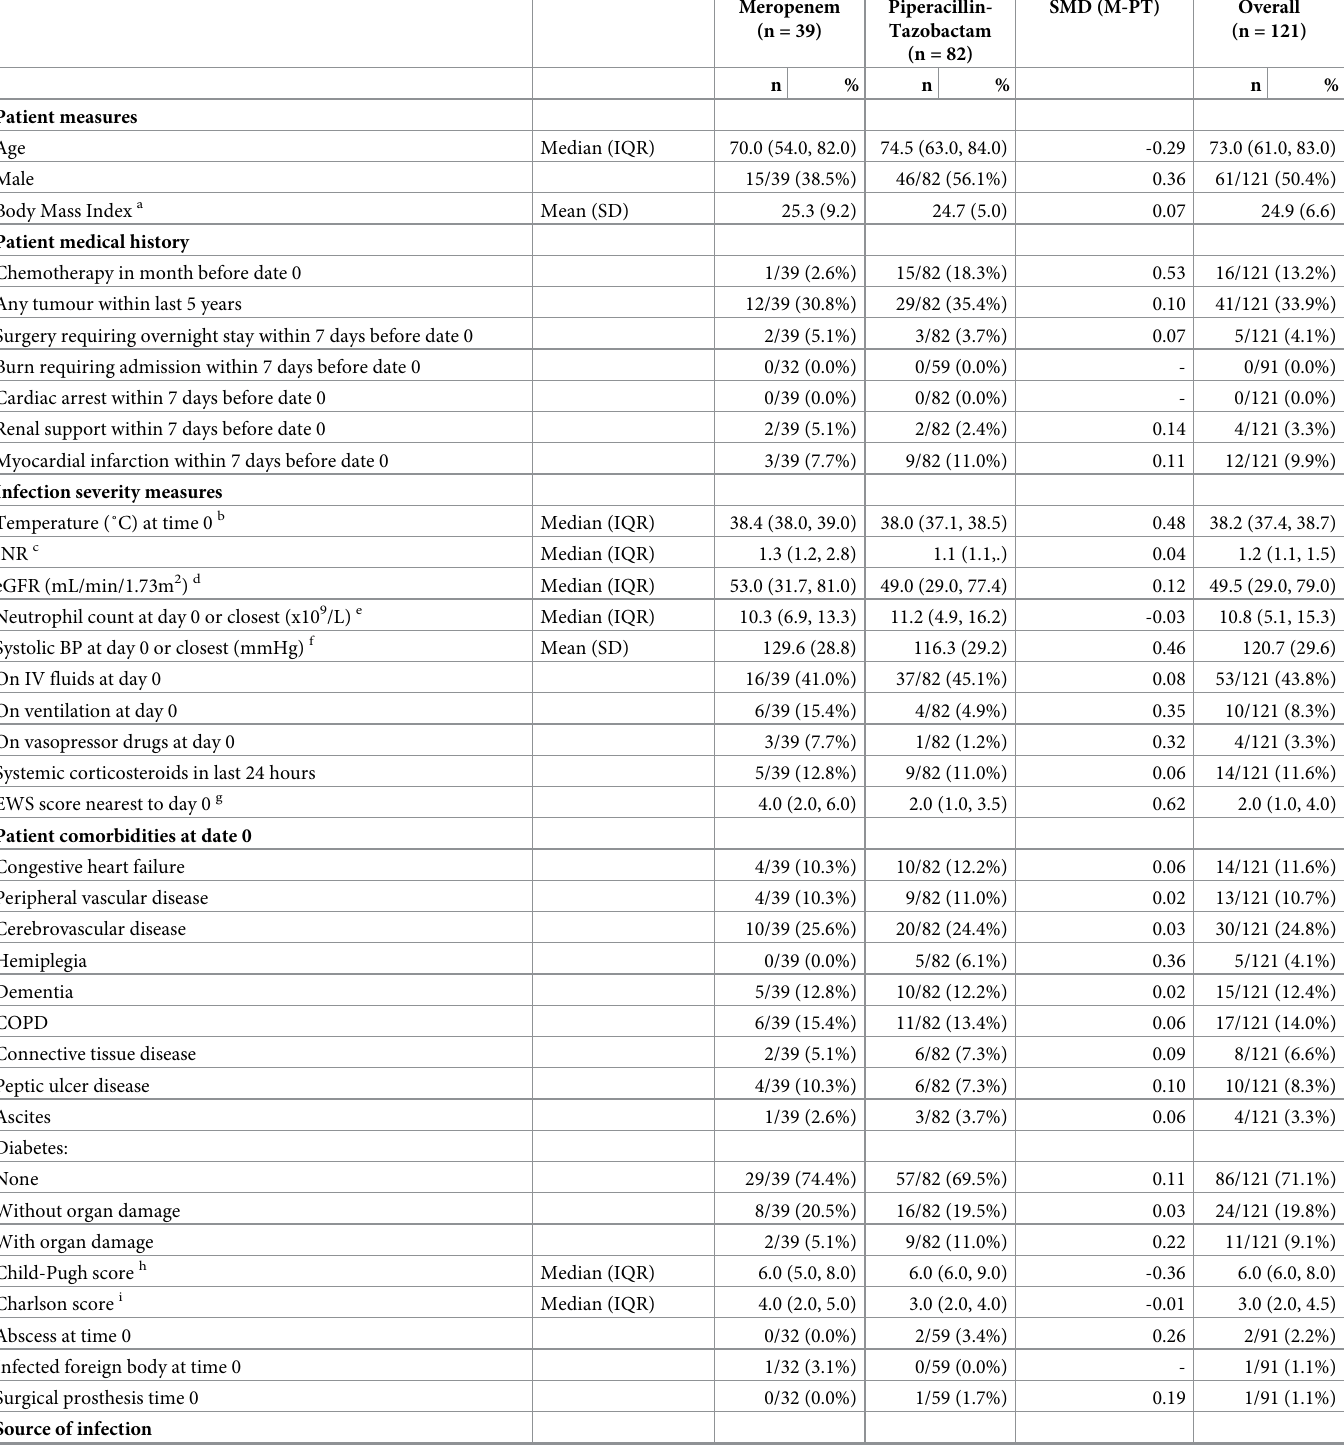
Table 2. Baseline characteristics of patients in the emulated trial population, by emulated